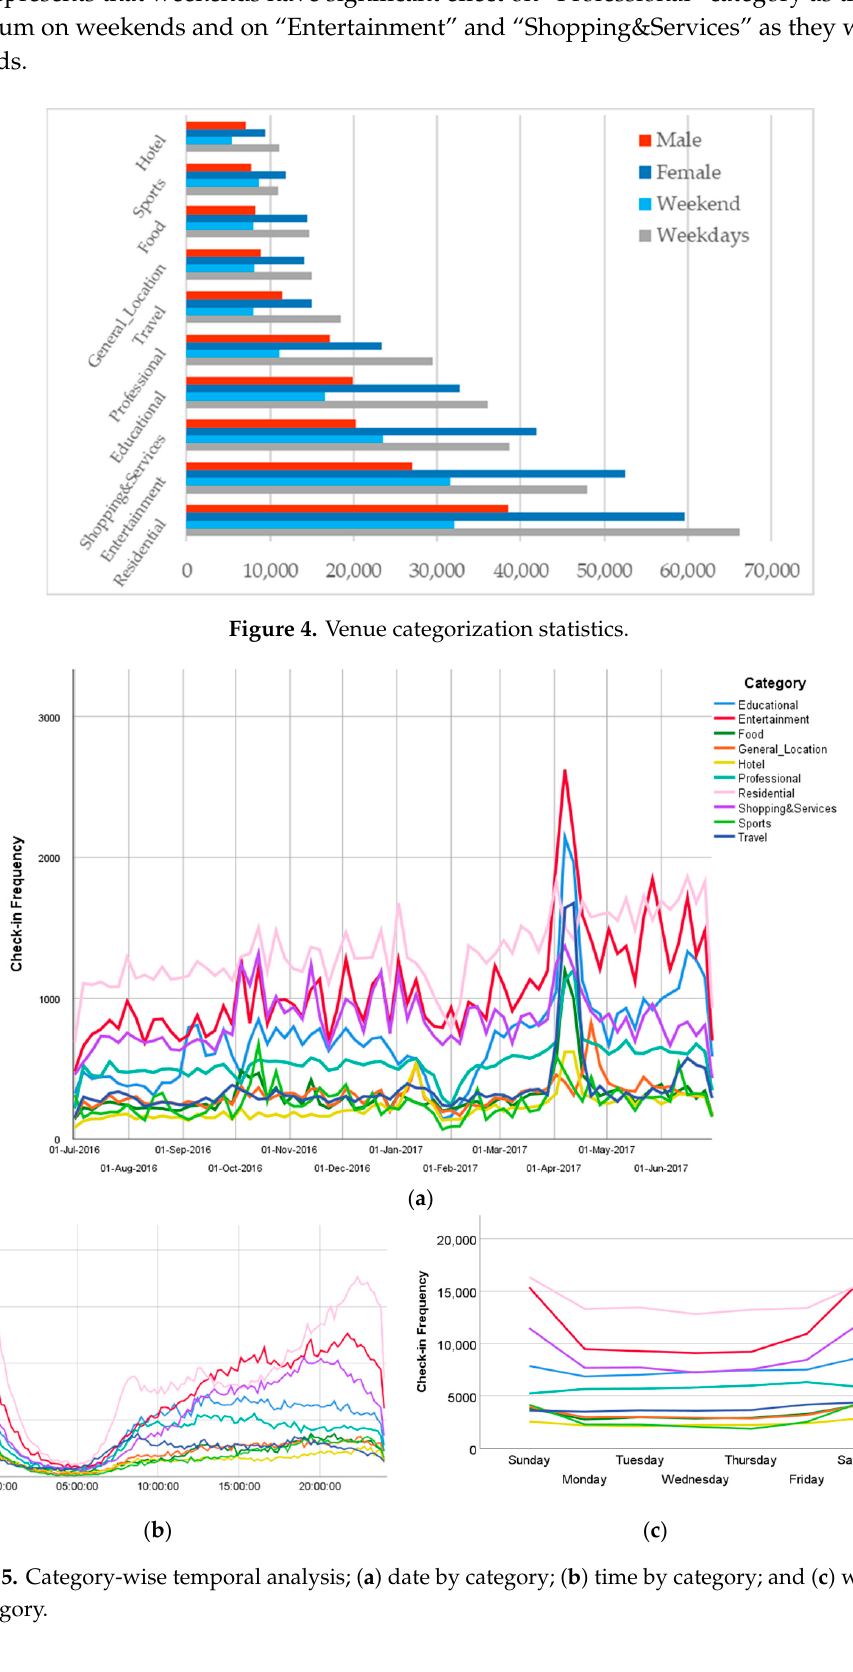
Figure 5. Category-wise temporal analysis; ( a ) date by category; ( b ) time by category; and ( c ) weekday by